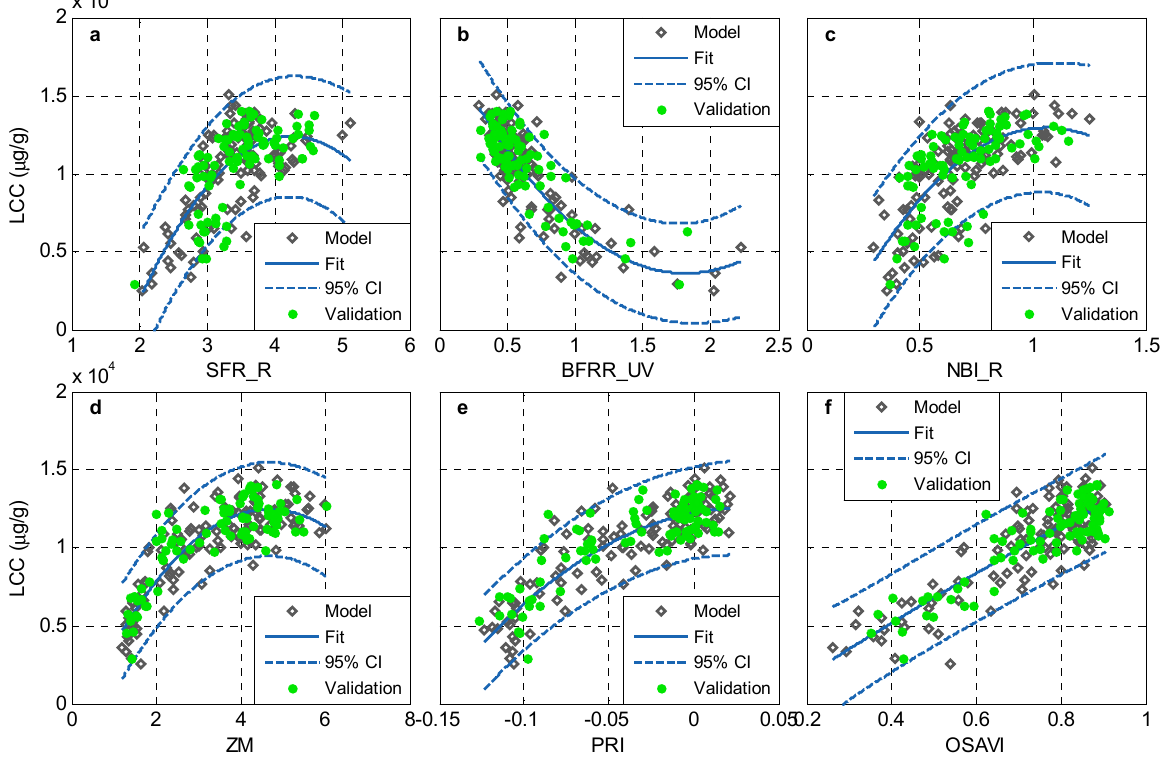
Figure 6. Fitting second order polynomial regression models to the calibration data for each of the indices for predicting LCC using the independent validation